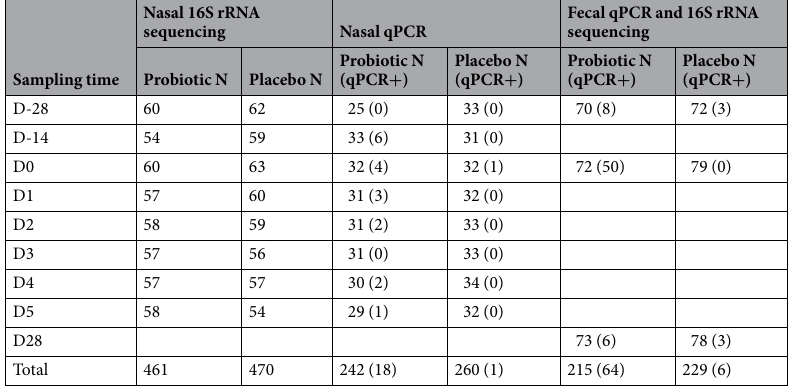
Table 1. Number and distribution of nasal and fecal samples between study groups at different sampling times and number of Bl-04 positive samples by qPCR (qPCR +